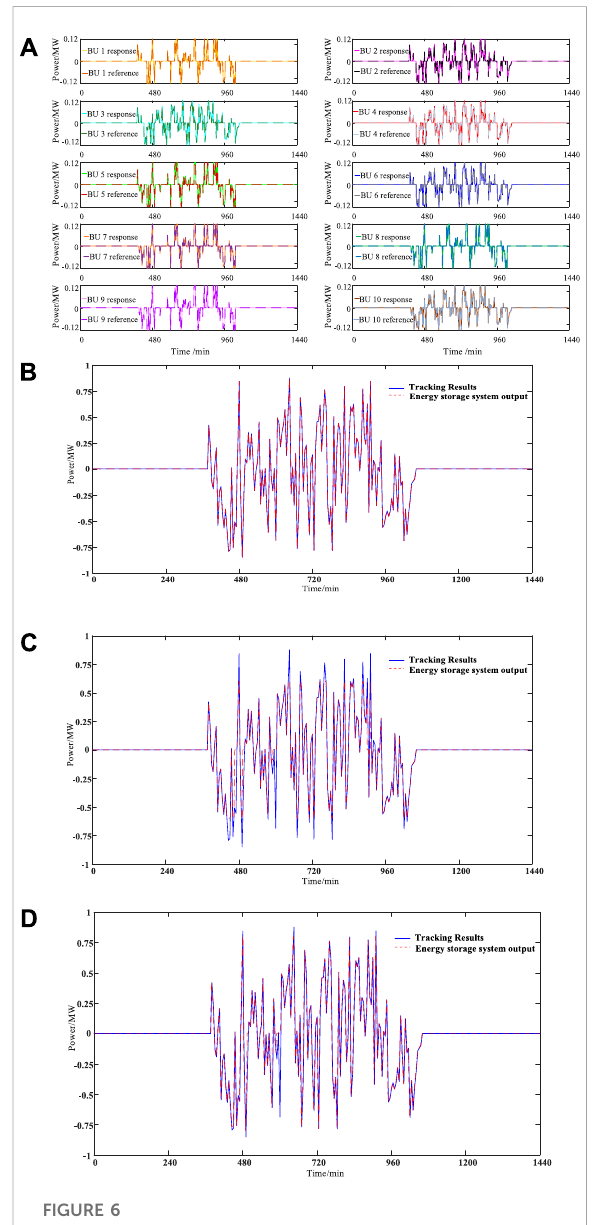
FIGURE 6 (A) Tracking results of the power references by the battery units. (B) Tracking result of the power reference by BESS for proposed approach. (C) Tracking result of the power reference by BESS for approach-IV. (D) Tracking result of the power reference by BESS for